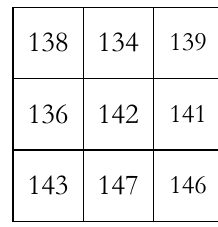
Figure 3. Grid consisting of nine cells and the corresponding